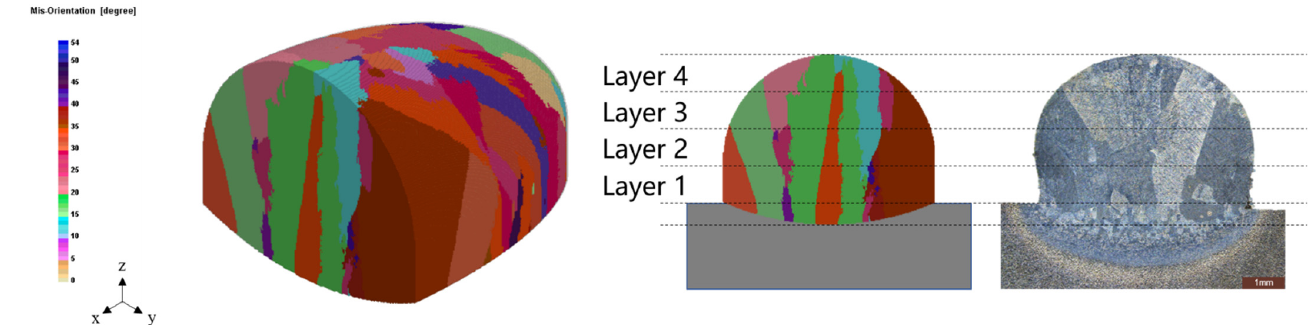
Figure 16. The 4-layer microstructure by the CA simulation. Figure 16. The 4 ‐ layer microstructure by the CA simulation. Table 3. The nucleation and grain growth simulation parameters. Table 4. The experiment and simulation comparison of the four ‐ layer microstructures. Parameter Value Experiment CA Relative Error (%) Average length Liquidus temperature (°C) 1650 1.97 Solidus temperature (°C) 1554 (mm) Maximum nucleation density, n max (m − 3 ) 1 × 10 9 Average of supercooling, ∆ T n (k) 32 Standard deviation of supercooling, ∆ T σ (k) 8 Coefficient of growth, α 0 Coefficient of growth, β 3.19 × 10 − 5